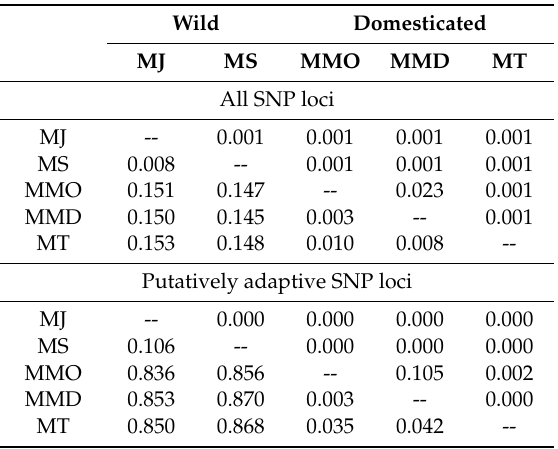
Table 5. Pairwise F ST values (below diagonal) and associated p values (above diagonal) for the all SNPs loci and putatively adaptive SNP loci of giant tiger shrimp Penaeus monodon wild and domesticated broodstock populations collected from di ff erent Indo-Pacific regions.